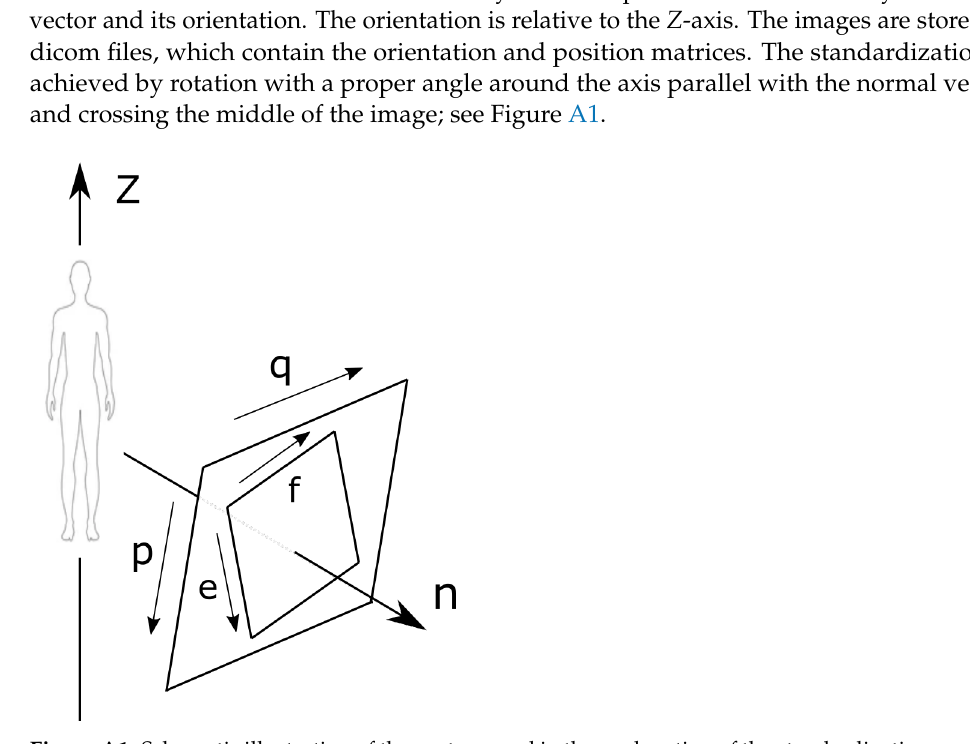
Figure A1. Schematic illustration of the vectors used in the explanation of the standardization